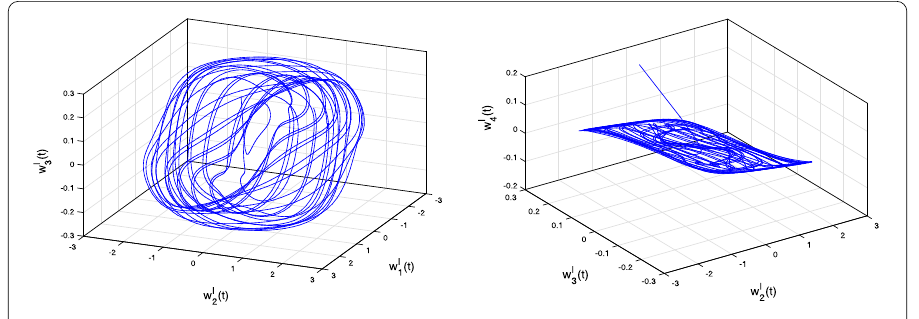
Figure 2 Imaginary part of state variables of FOCVNN (26)